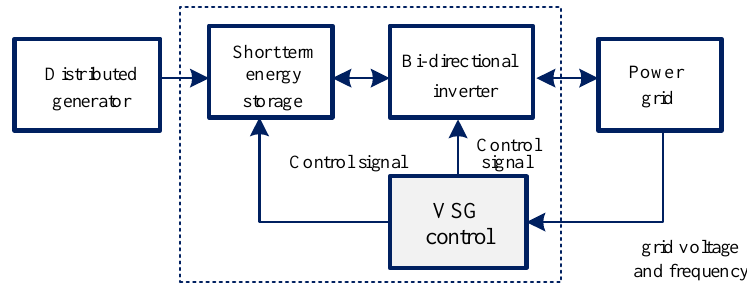
Figure 6. Principle of the VSG.